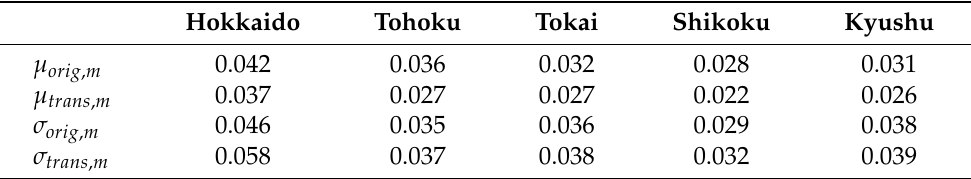
Table 3. The MAD between the AHI or transformed AHI NDVI and MODIS NDVI ( µ orig , m and µ trans , m ), and the SD for the NDVI differences ( σ orig , m and σ trans , m ) obtained using NDVI data for pixel-by-pixel